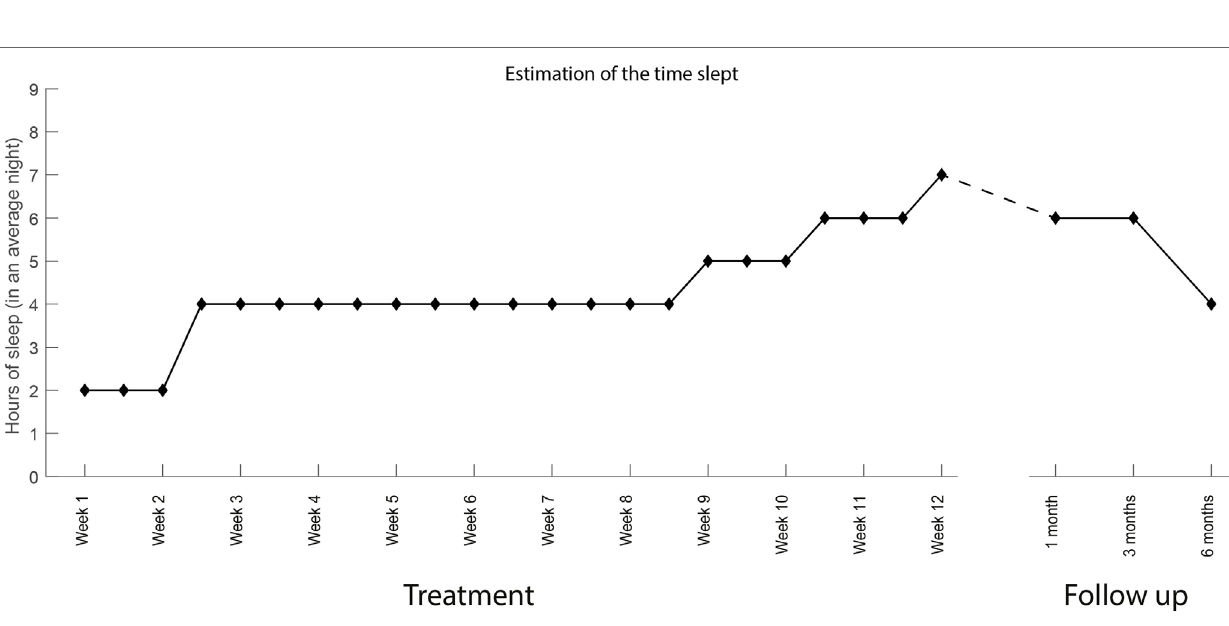
FigUre 10 | Time slept as estimated by the subject over the course of the treatment and during the follow-up period.